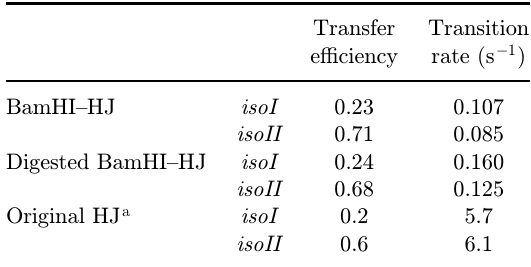
Table 1. Results of